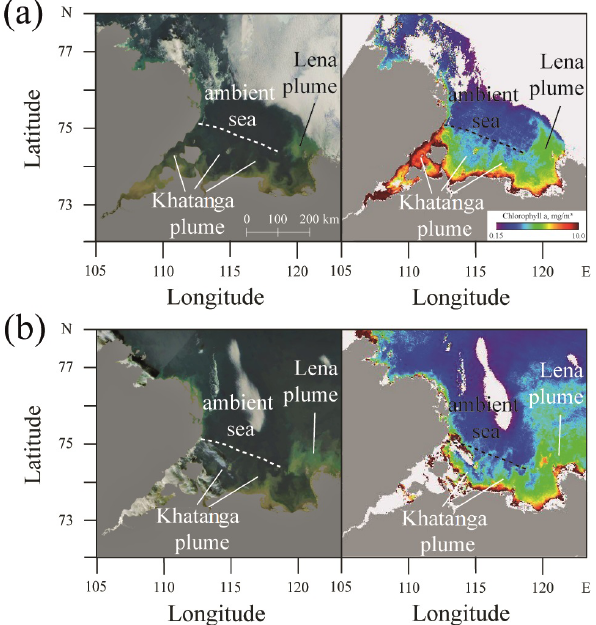
Figure 9. Corrected reflectance (left) and concentration of chloro- phyll a (right) from MODIS Terra satellite images of the western part of the Laptev Sea acquired on 23 September (a) and 25 Septem- ber (b)